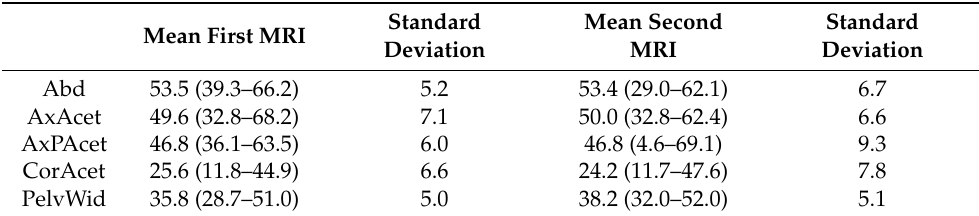
Table 4. Summary of the magnetic resonance imaging (MRI) measurements in the first and last MRI. Abd = hip abduction angle. AxAcet = axial anterior acetabular angle. AxPAcet = axial